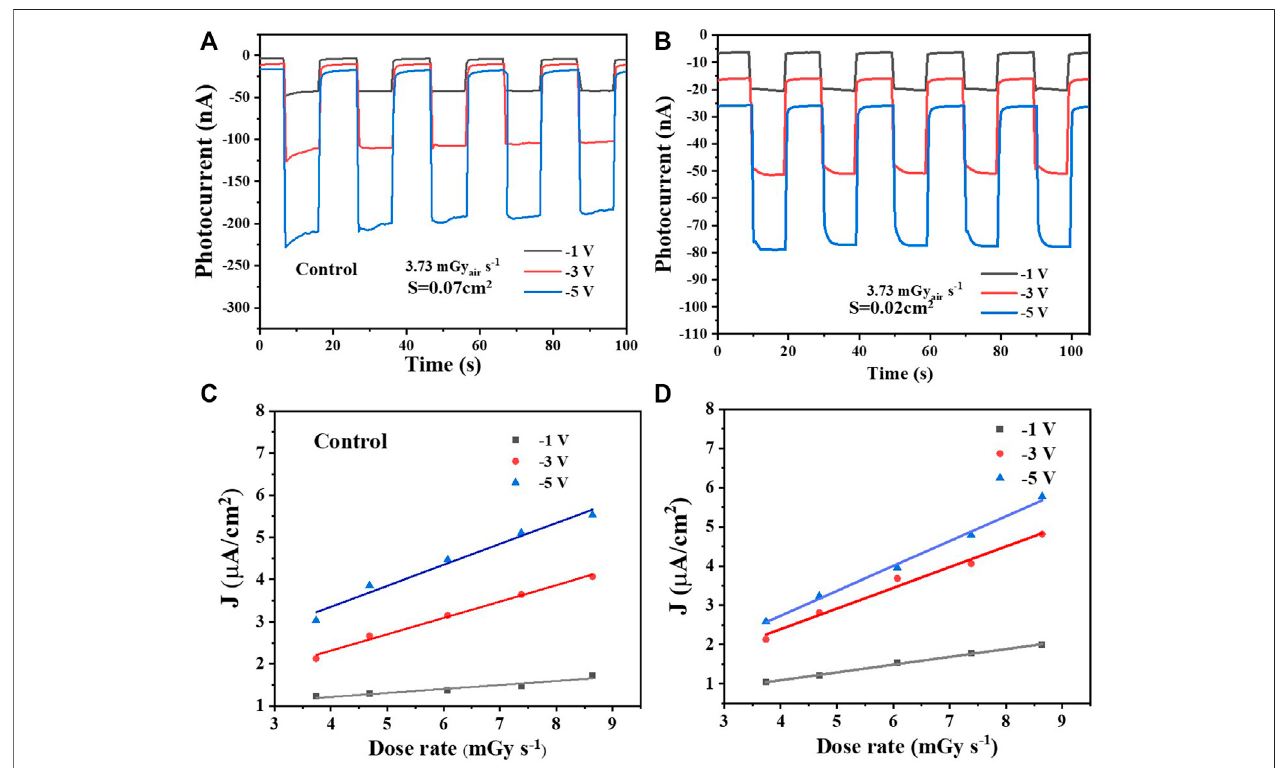
FIGURE 6 | X-ray response of the control device (A) and O 3 – UV-treated device (B) under various bias. (C) – (D) Summary of the photocurrent of the two single- crystal detectors under various dose rates and bias.